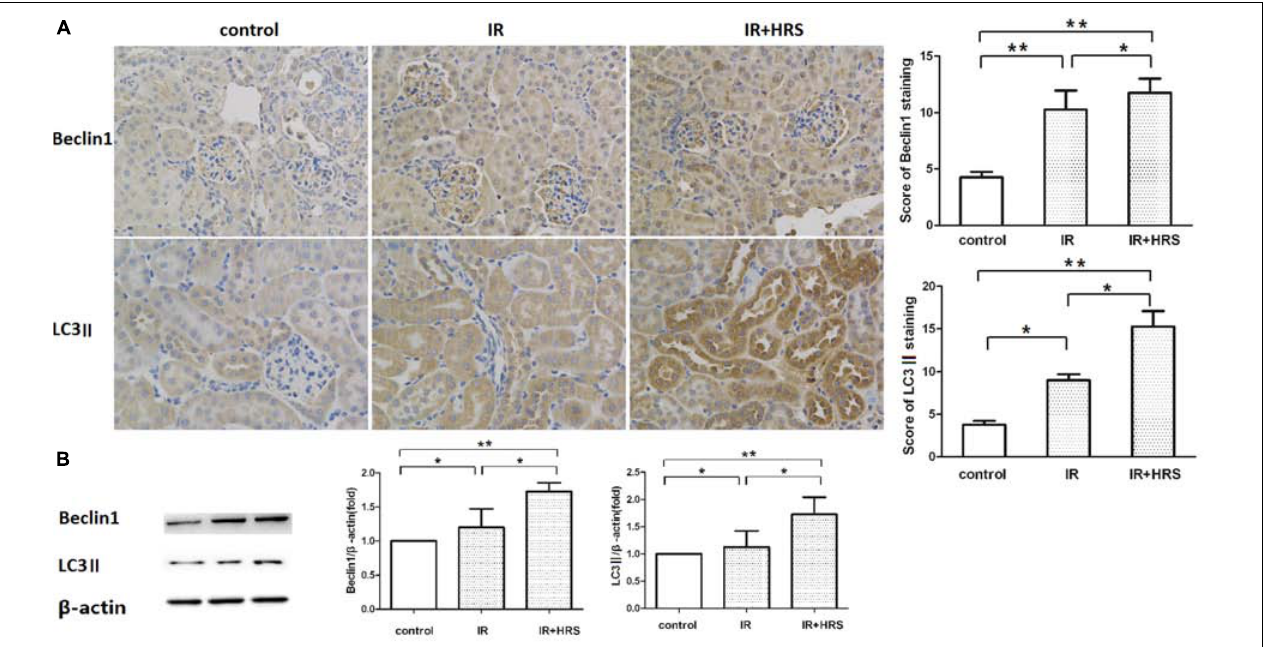
FIGURE 3 | The expression of autophagy markers in these groups. (A,B) HRS enhanced the protein levels of autophagy markers in renal tissues of IR mice 28 days after reperfusion. Renal samples were collected 28 days after reperfusion to measure Beclin-1 and LC3-II expression levels by immunohistochemistry and western blot. LC3-II and Beclin-1 in the IR group were concurrently increased, compared to the sham group ( ∗ P < 0.05). HRS treatment significantly elevated LC3-II and Beclin-1 expression levels compared with the IR group ( ∗ P < 0.05).